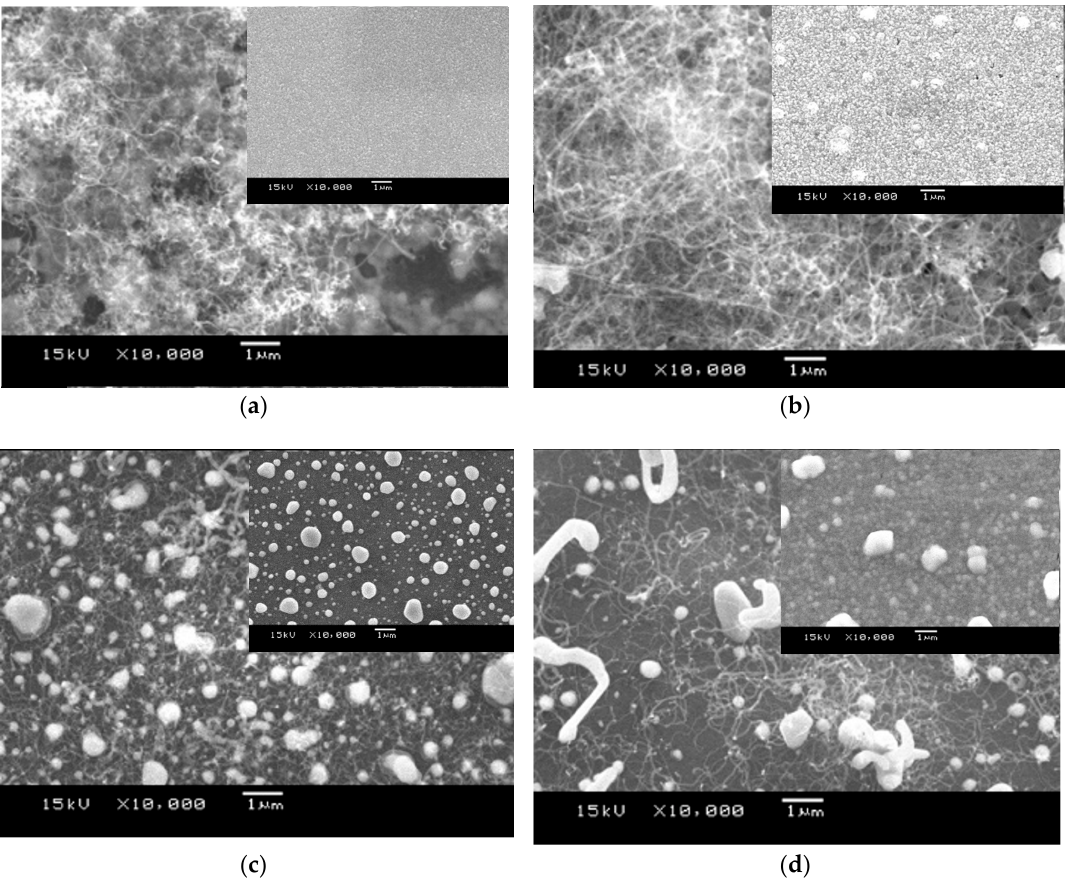
Figure 2. SEM images of different carbon nanostructures (CNS) after C 2 H 2 /H 2 -chemical vapor deposition (CVD): ( a ) 100 nm Cu film; ( b ) 500 nm Cu film; ( c ) 100 nm Cu-Cr alloy film; ( d ) 500 nm Cu-Cr alloy film.